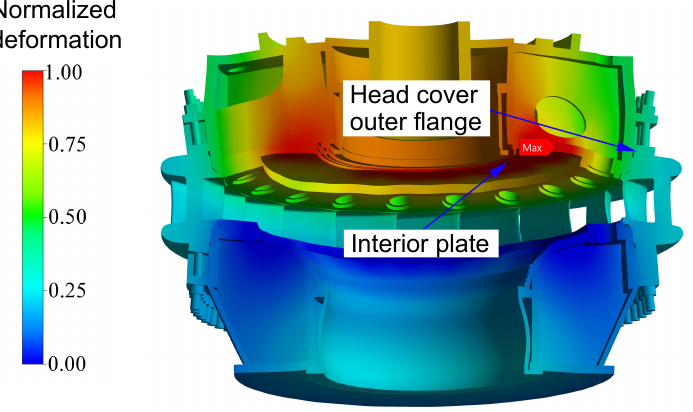
Figure 12. The deformation distribution of the non-rotating structures (longitudinal section).